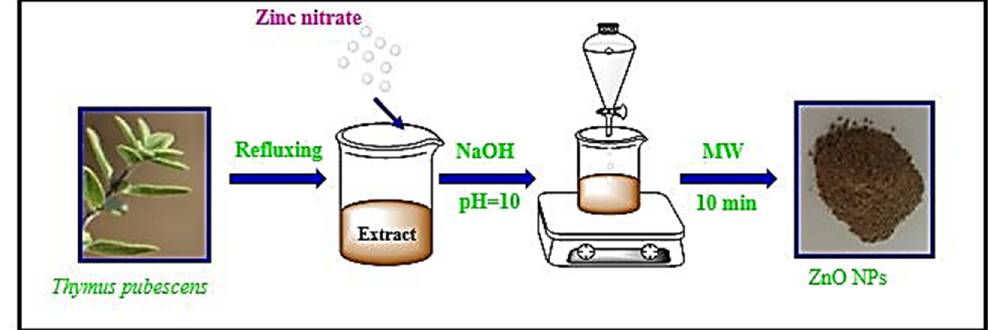
Figure 8. Fabrication scheme of ZnO-NPs from Zinc nitrate using leaf extract of plant Thymus pubescens.